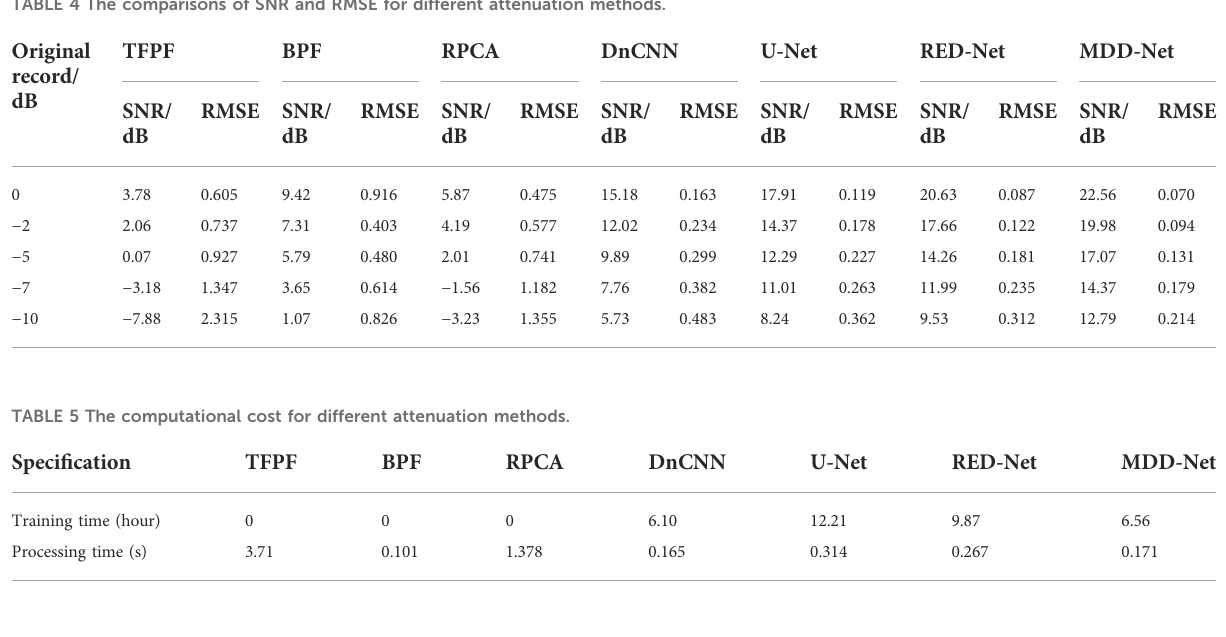
TABLE 4 The comparisons of SNR and RMSE for different attenuation methods.